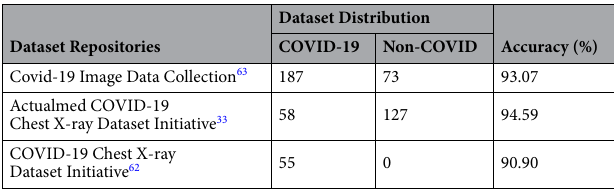
Table 2. Cross-dataset evaluation results for COVID-19 detection.